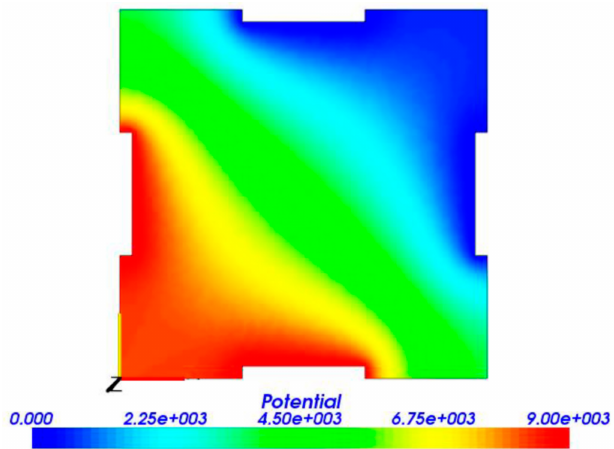
Figure 12. The potential distribution (V).